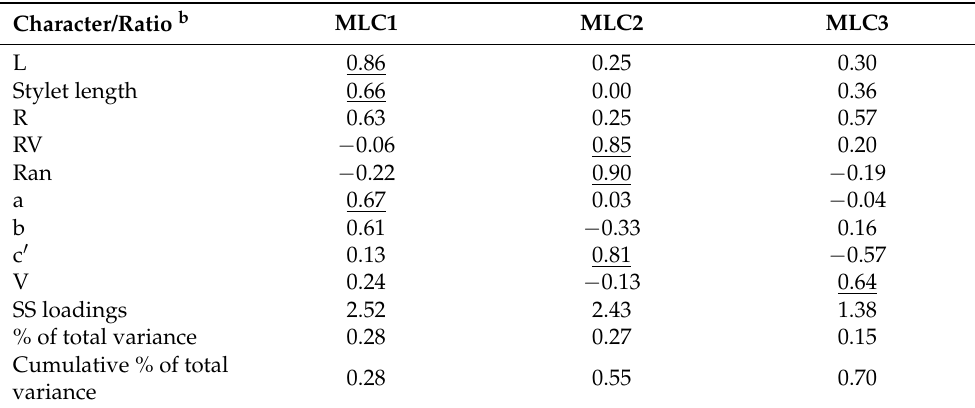
Table 1. Eigenvector and SS loadings of factor analysis from morphometric characters for Criconema annuliferum species complex ( C. annuliferum , C. paraannuliferum , C. plesioannuliferum , C. pseudoan- nuliferum sp. nov.) a